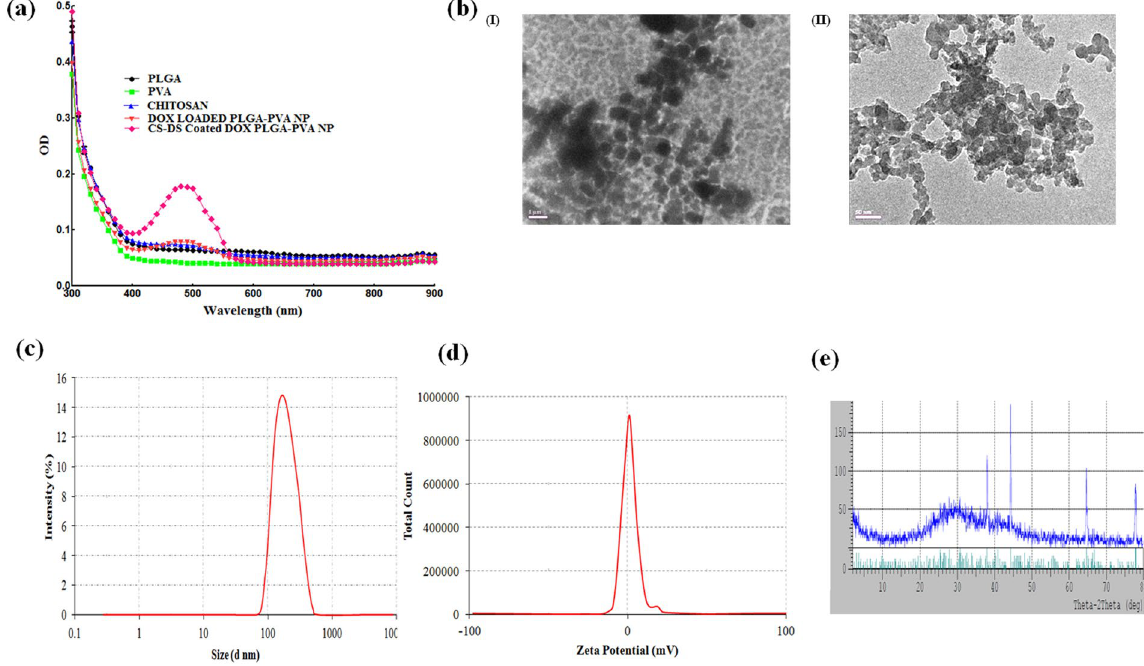
Figure 1. Characterization of DOX nanoparticles. ( a ) UV-Vis spectral analysis of PLGA, PVA, Chitosan, DOX loaded PLGA-PVA NP and CS-DS coated DOX loaded PLGA-PVA NP. ( b ) (I) and (II) DOX loaded PLGA- PVA NP and CS-DS coated DOX loaded PLGA-PVA -NP size and shape analysis by TEM, respectively. ( c ) Size distribution analysis of CS-DS coated DOX loaded PLGA-PVA NP. ( d ) Zeta potential analysis showing surface charge distribution of CS-DS coated DOX loaded PLGA-PVA NP. ( e ) XRD pattern of CS-DS coated DOX loaded PLGA-PVA NP. Images are representative of three different